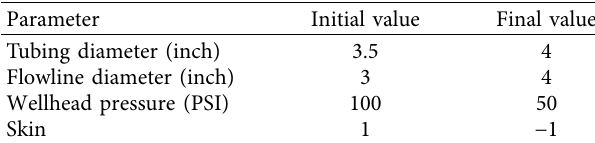
Figure 7: Nodal analysis after adjustments. Table 4: Optimized parameter